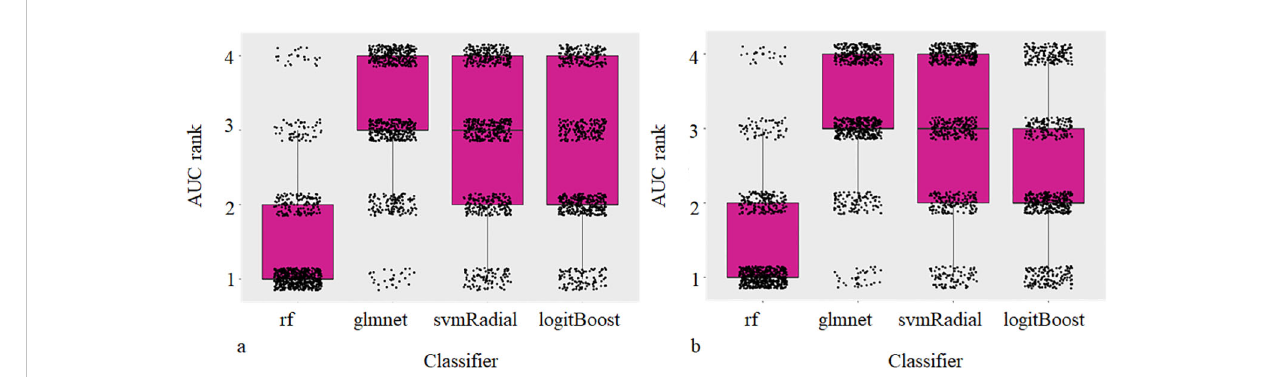
FIGURE 4 Box and Scatterplots showing area under the receiver operating characteristic curves (AUCs) rank values (lower being better) for different classi fi ers used over all datasets and repetitions for physical (a) and EQD2 dosiomics analysis